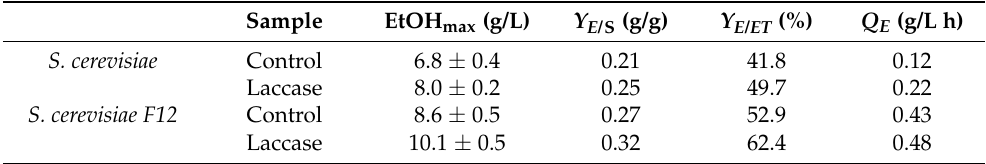
Table 4. Summary of fermentation assays with S. cerevisiae Ethanol Red and S. cerevisiae F12 using laccase-treated liquid